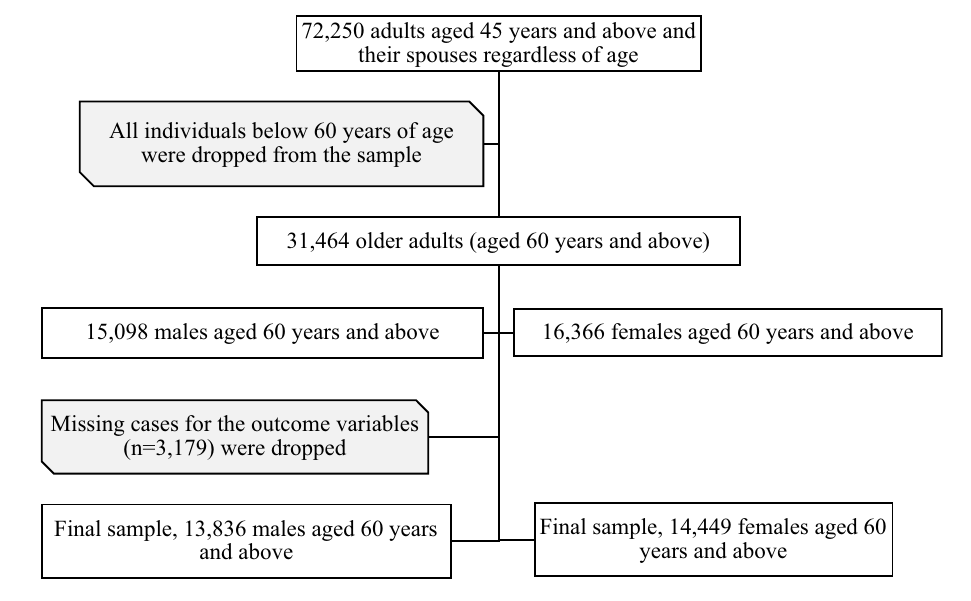
Figure 1. Sample selection criteria for this